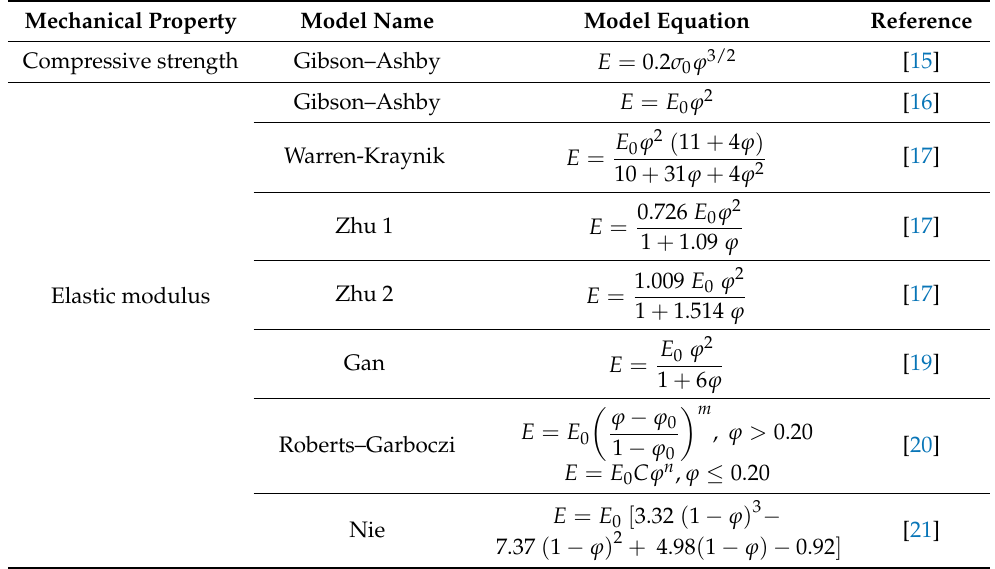
Table 1. Potentially suitable models to estimate σ c and E of hydroxyapatite